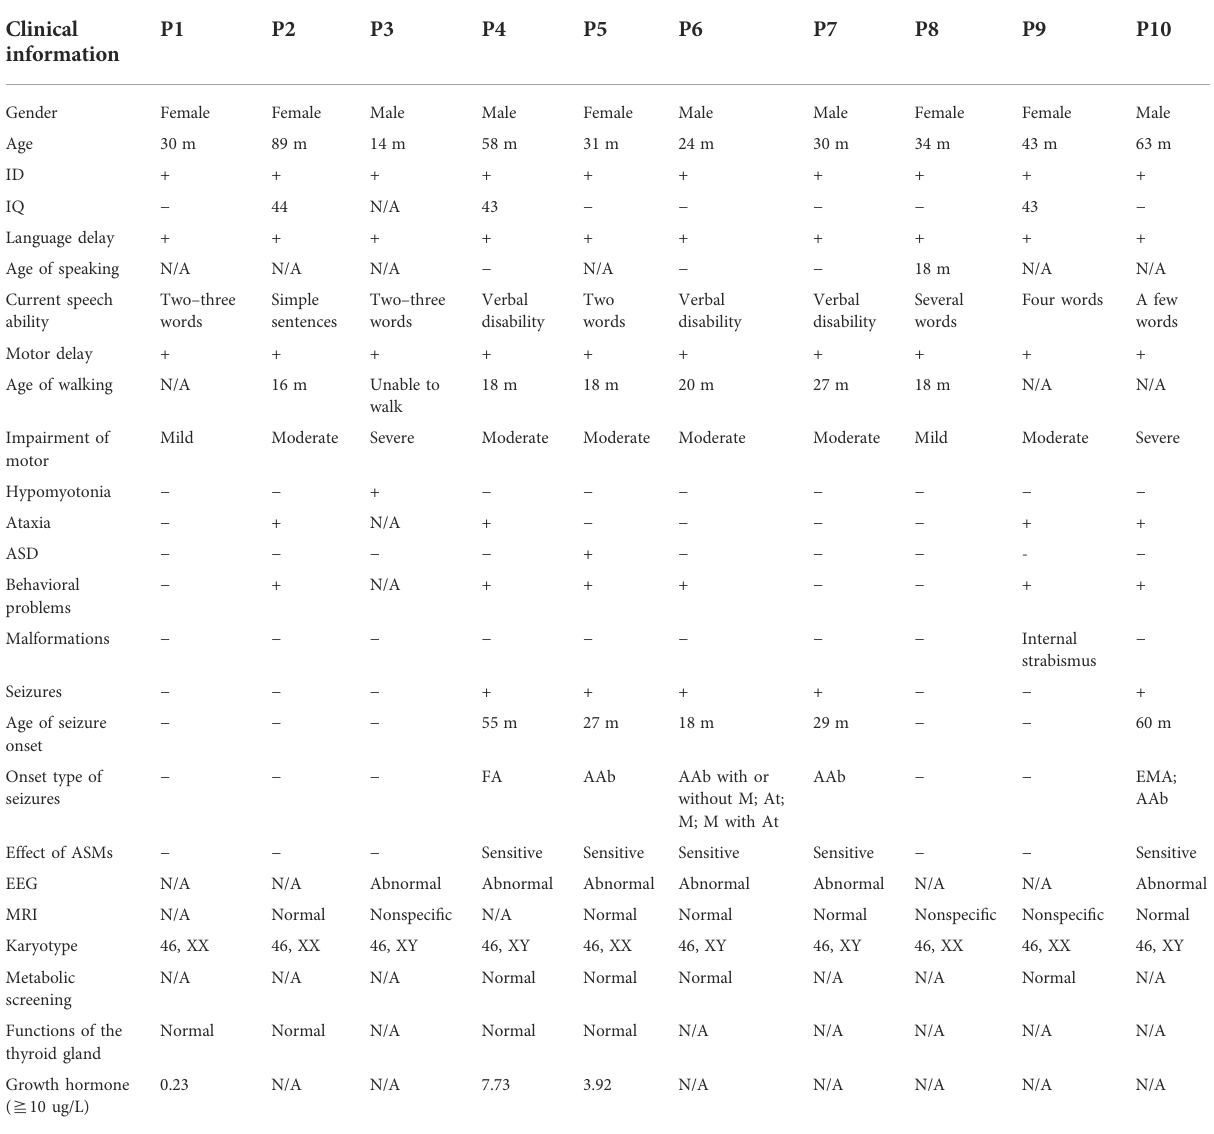
TABLE 1 Clinical information of 10 Chinese